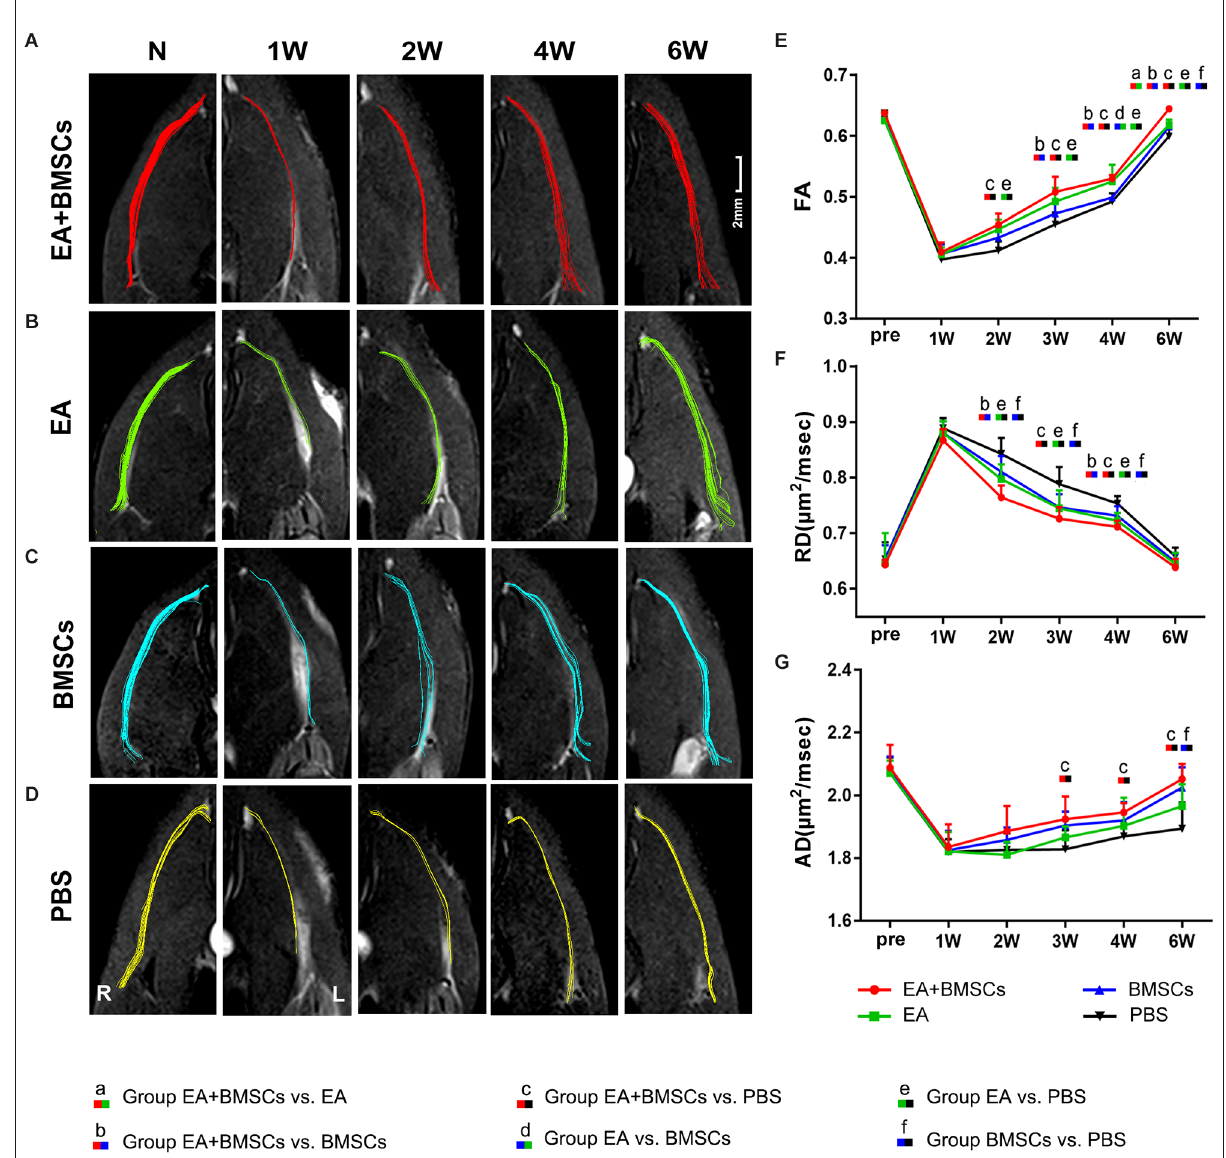
FIGURE3 DTI of injured sciatic nerves in rats. (A–D) DTT of injured sciatic nerves compared to uninjured contralateral nerves after surgery. Images depicting the injured nerves in the EA + BMSCs, EA, BMSCs, and PBS subgroups on the left and the uninjured nerves (control group) on the right. R: right, L: left, W: week. (E–G) Six weeks after surgery, FA, RD, and AD values in the distal stumps of all injured nerves were compared to their respective control values. The FA, RD, and AD values of acquisition points within groups were compared by using repeated-measures one-way ANOVA with Bonferroni post hoc testing, and Table 2 lists statistically significant differences. DTI, diffusion tensor imaging; DTT, diffusion tensor tractography; EA, electroacupuncture; BMSCs, bone mesenchymal stem cells; PBS, phosphate-buffered saline; FA, fractional anisotropy; RD, radial diffusivity; AD, axial